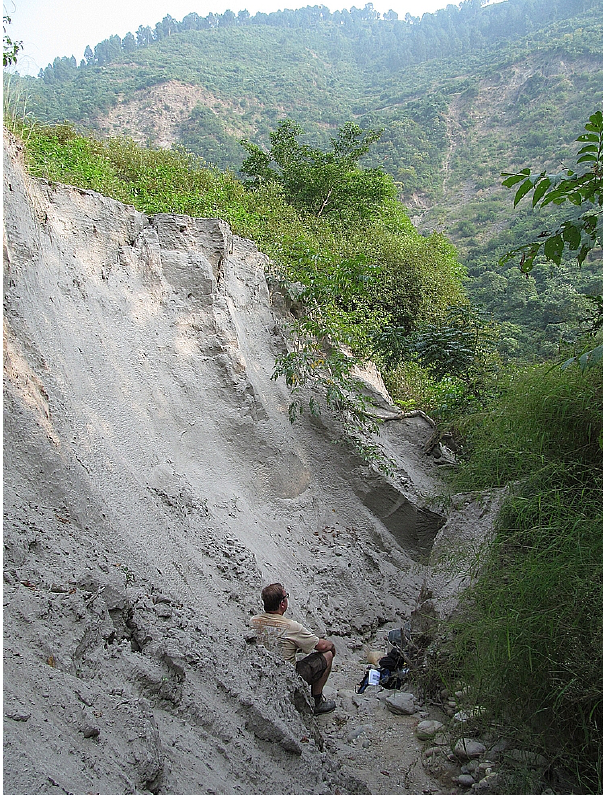
Figure A16. DV2013 – laminated sand deposit ∼ 5 to 10m thick formed in single event following the 2013 Alaknanda